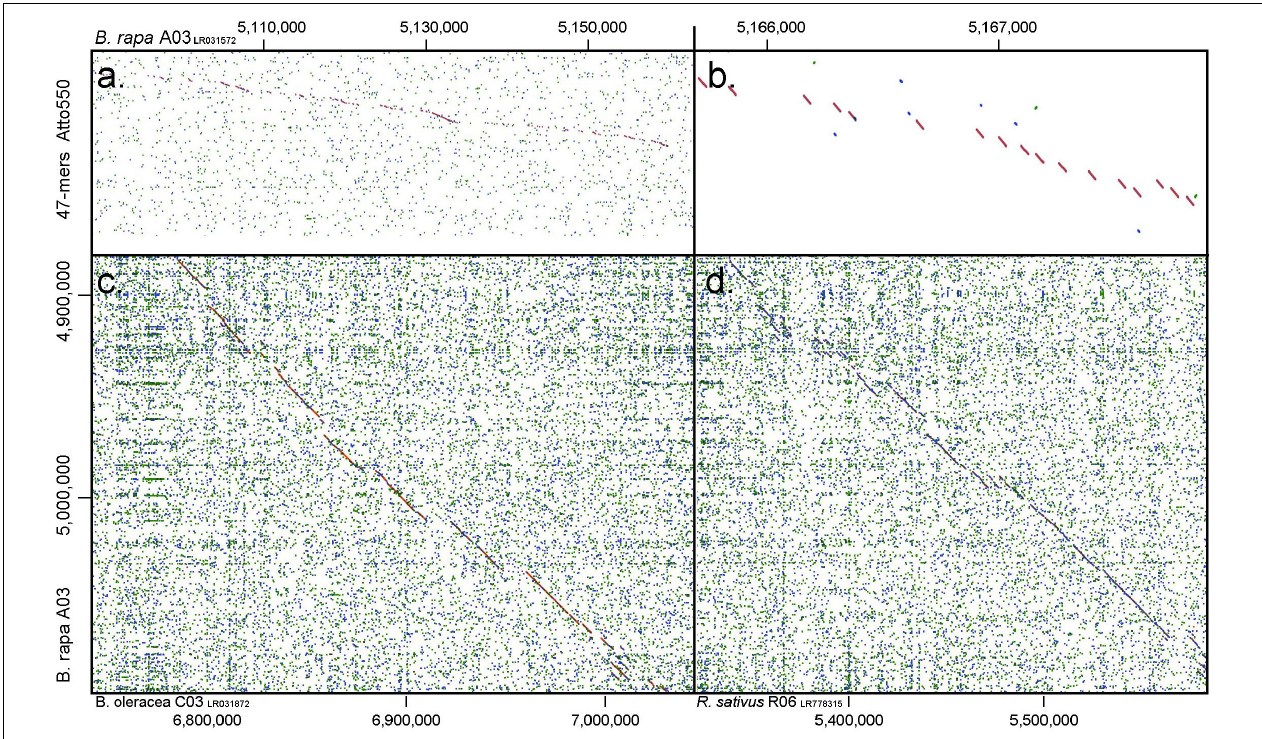
FIGURE 3 | Dot plots depicting similarity between (a,b) oligonucleotide pool of 47-mers labeled with Atto550 and B. rapa chromosome A03 (1.0 gramene.org, y-axis): gaps show regions where nucleotides have been deleted by the selection procedure; and comparing A03 with (c) B. oleracea C03 and (d) Raphanus sativus R06. Diagonal lines show regions of high similarity where oligonucleotide probes would hybridize to both genomes, while gaps indicate insertions in one of the genomes or regions of lower homology.